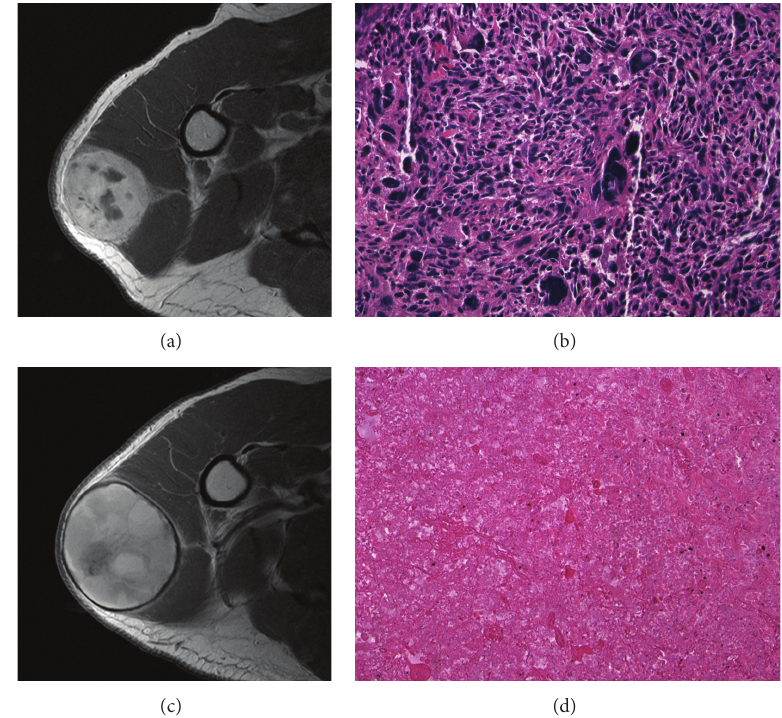
Figure 3: (a) Pre-operative axial T1 post-contrast MRI demonstrating a large, deep, soft tissue sarcoma contained within the deltoid musculature, and (b) the core needle biopsy specimen (Frozen Section, H&E, 20x) demonstrating high-grade undifferentiated pleomorphic sarcoma. (c) The same tumor on a restaging axial T1 MRI after pre-operative radiation demonstrating a thick fibrous rind. Also evident is that the tumor has grown slightly with radiation. (d) Histopathologic slide (H&E, 20x) from the resection specimen demonstrating substantial treatment effect from the